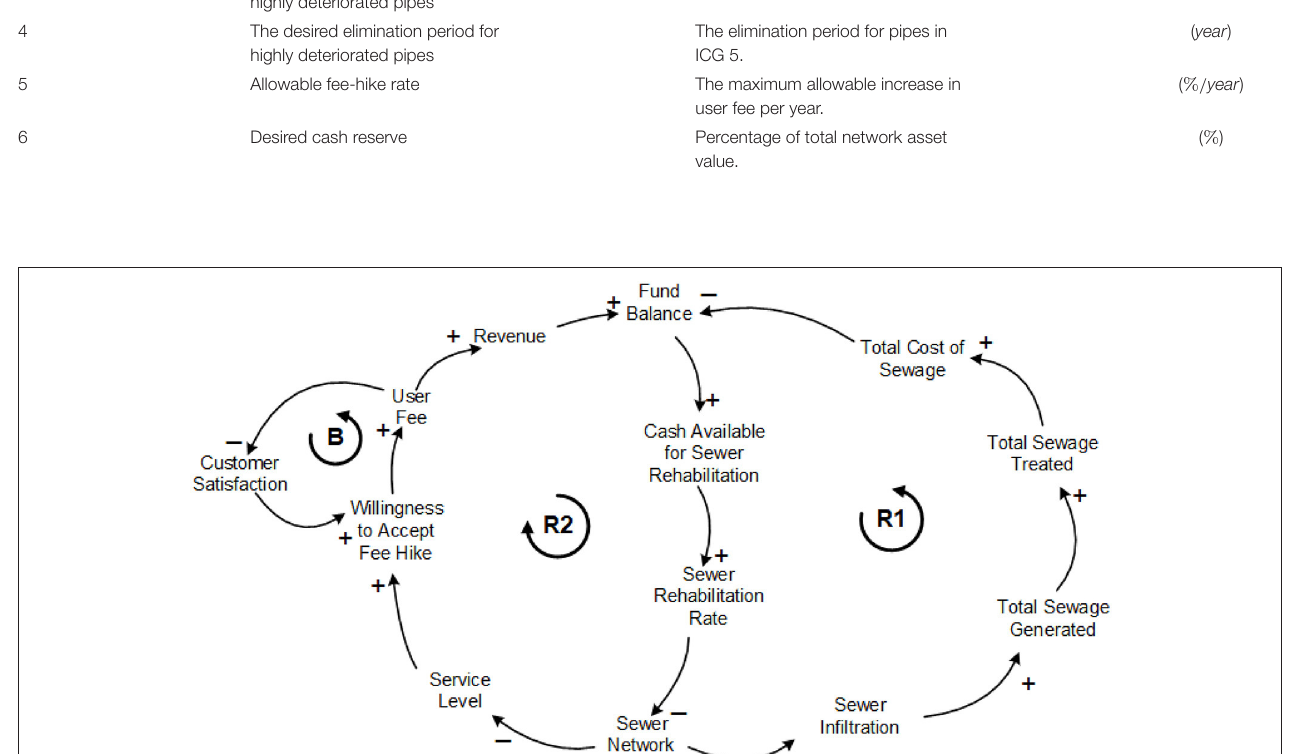
FIGURE 2 | A causal loop diagram example for asset management strategy of wastewater collection networks.